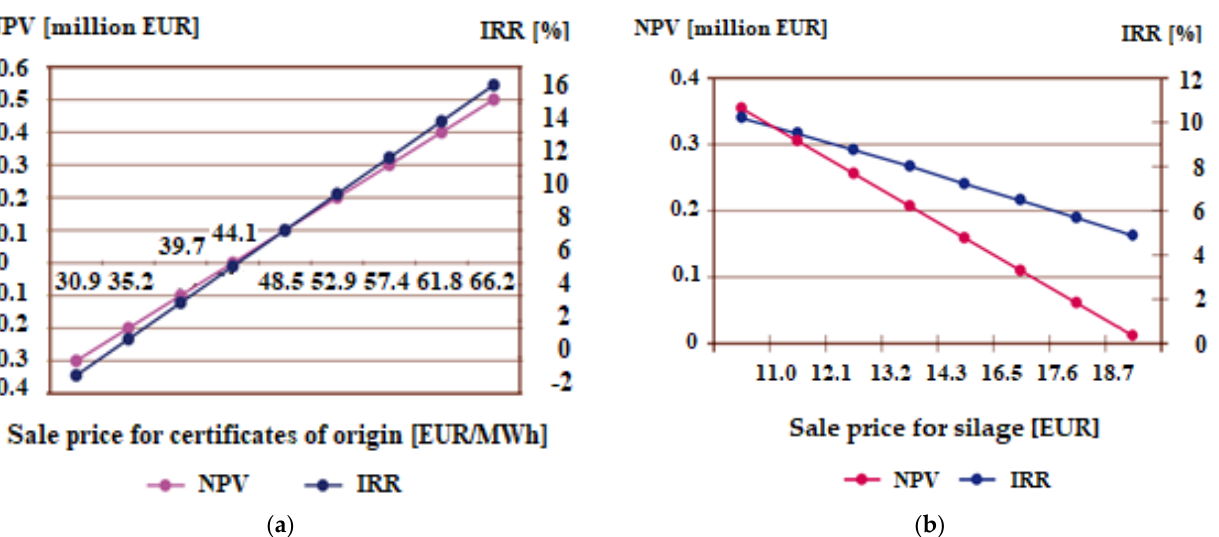
Figure 1. Dependencies of rates [108]: ( a ) impact of the sale price for certificates of origin on NPV and IRR, with a fixed sale price for electricity to the grid; ( b ) impact of the purchase price for corn silage on NPV and IRR.